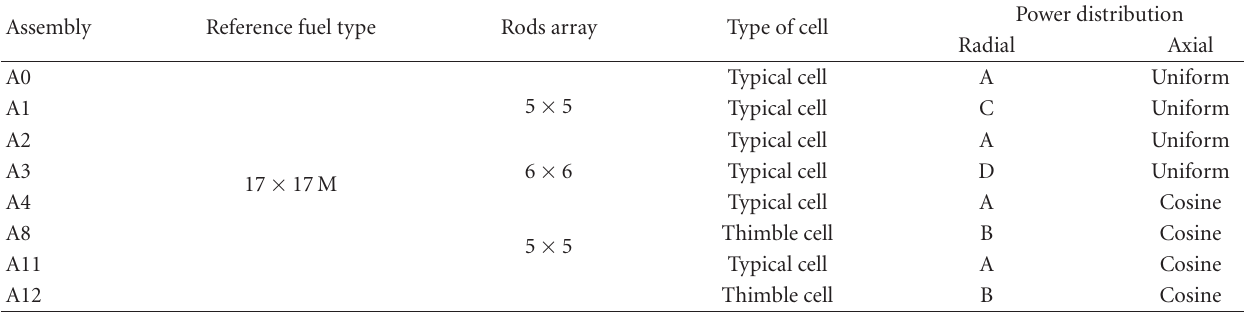
Table 8: Test assemblies for phase II